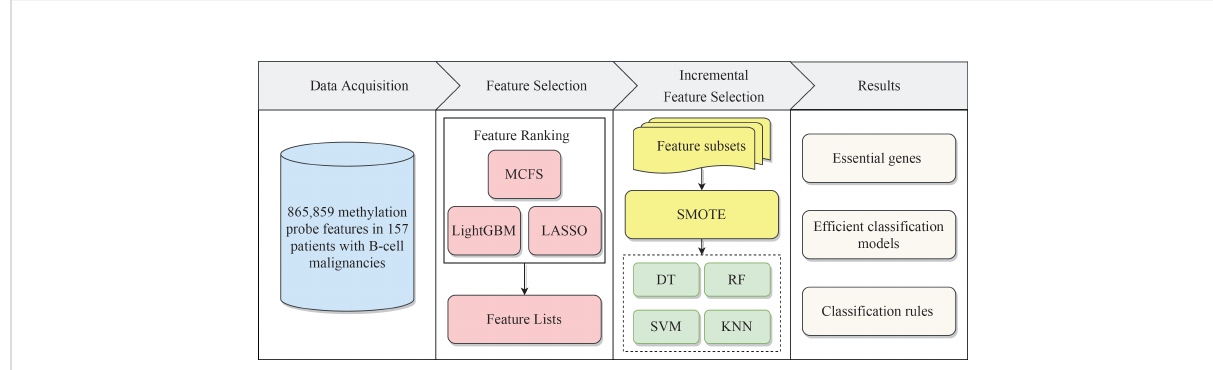
FIGURE 1 Flow chart of the entire analytical process. The 865,859 methylation probe signals on patients with B-cell malignancies were ranked according to feature importance by using three feature ranking algorithms, namely, MCFS, LightGBM, and LASSO. Then, three ordered feature lists were fed into the incremental feature selection (IFS) method, which incorporates four classi fi cation algorithms. Finally, based on the IFS results, the essential genes, ef fi cient classi fi cation models and classi fi cation rules were